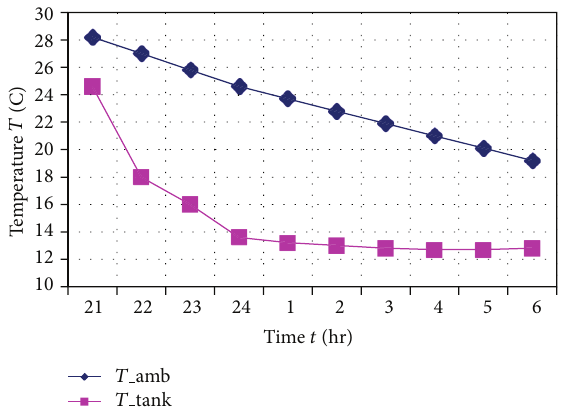
Figure 7: Wind velocity in the four locations.